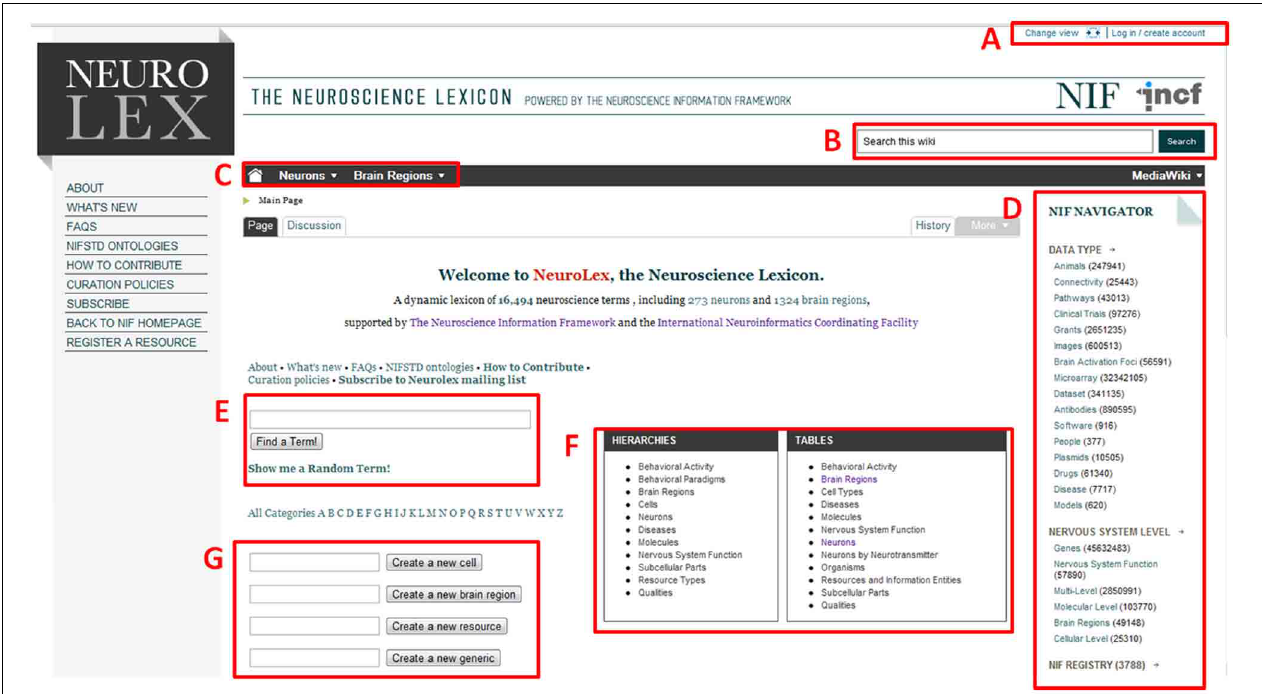
FIGURE 1 | Landing page for NeuroLex.org. Several features are highlighted. (A) Login/user management controls. (B) Global site search bar. (C) Quick navigation to neuron or brain region information. (D) NIF Navigator, connecting the Neuroscience Information Framework B ’s federated resources